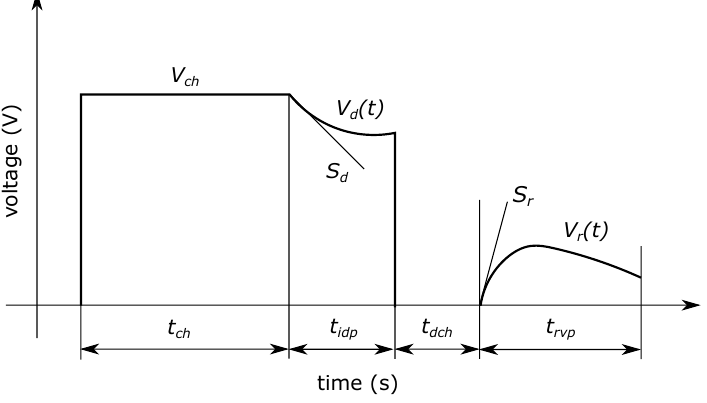
Figure 9. Timing diagram of Voltage Response measurement.